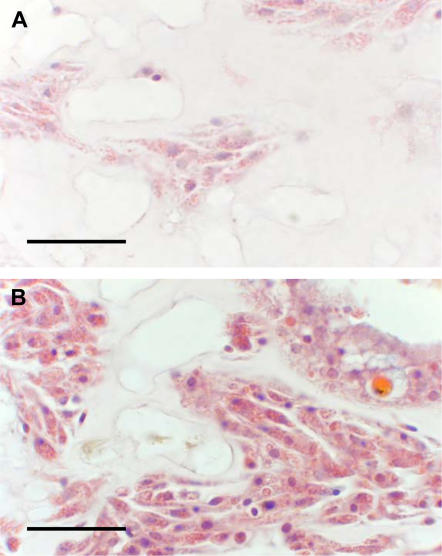
Amoebocytes in mesoglea (connective tissue) of sea fan corals exposed to experimental heat stress.Images are of the same coral colony, with A) one fragment kept at 29°C and B) fragment kept at 31.5°C. Scale bar = 25 µm.